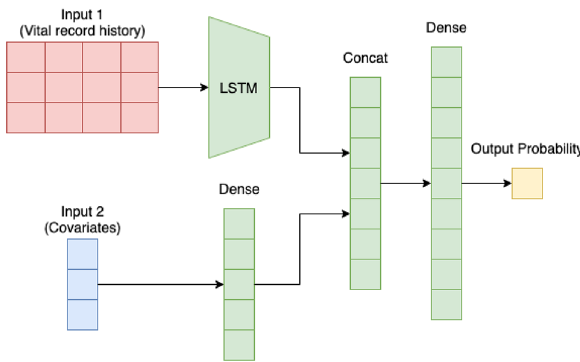
Figure 5. LSTM model architecture used in our